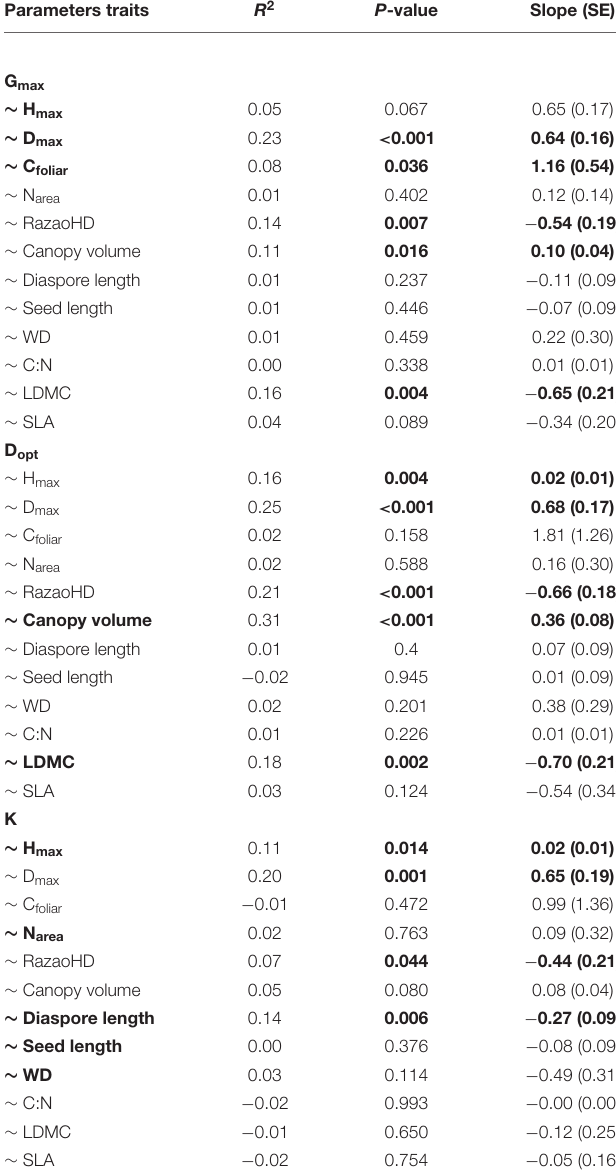
TABLE 2 | Regression statistics for individual linear regressions between growth trajectory parameters (maximum growth rate – G max , diameter at maximum growth rate – D opt , and the ontogenetic variability in growth rate – K) and traits (maximum height – H max , maximum diameter – D max , leaf carbon content – C foliar , nitrogen content -N area , leaf dry-mass content -LDMC, height to diameter ratio – RatioHD, Canopy volume, Diaspore length, seed length, wood density -WD, leaf carbon–nitrogen ratio – C:N, specific leaf area – SLA) for 45 tropical tree species. Tree species list are provided in Supplementary Table 1 . Parameters in bold represent the best model. Significant P -values and slopes are also highlighted in